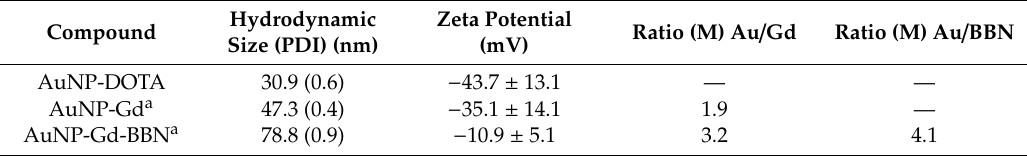
Table 2. Hydrodynamic size and zeta potential (pH 6), Gd / Au, and BBN / Au ratios of the AuNPs. Compound